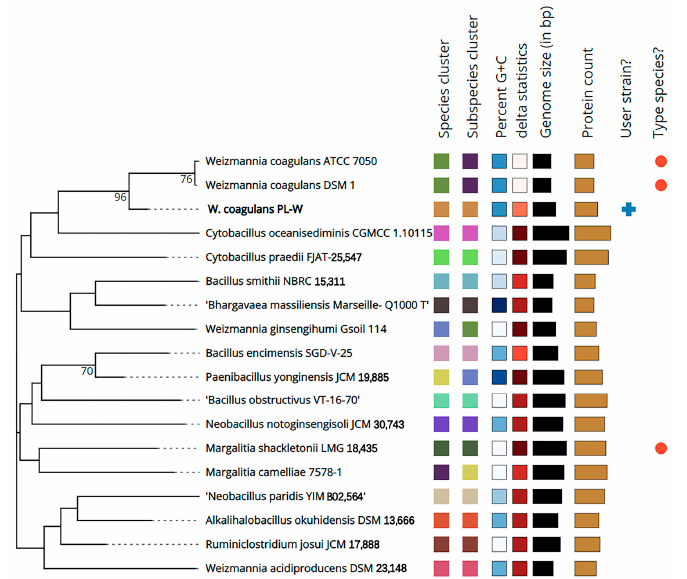
Figure 5. Phylogenetic analysis of W. coagulans PL-W whole genome by TYGS.